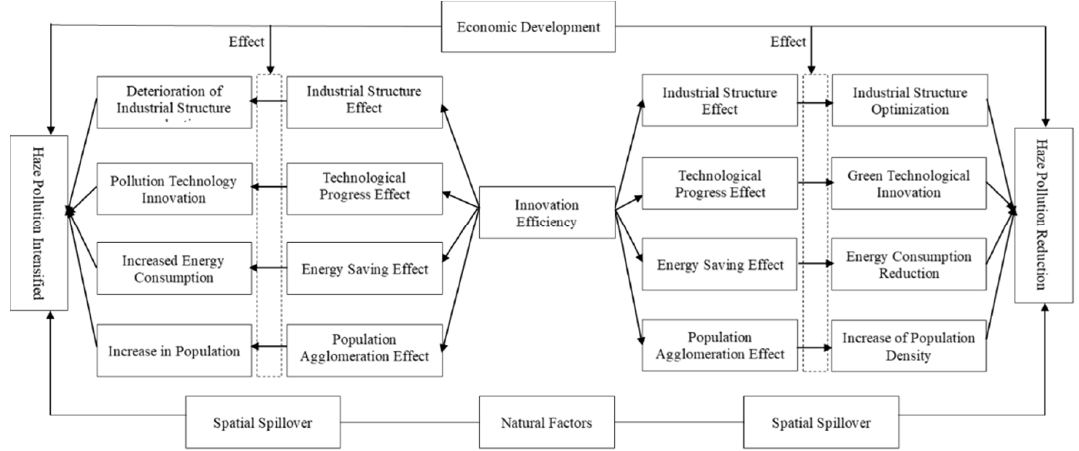
Figure 1. The mechanism of innovation efficiency on haze pollution.